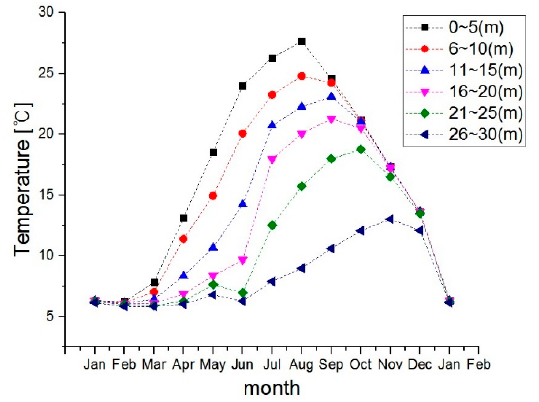
Figure 8. Monthly temperature changes by water depth.